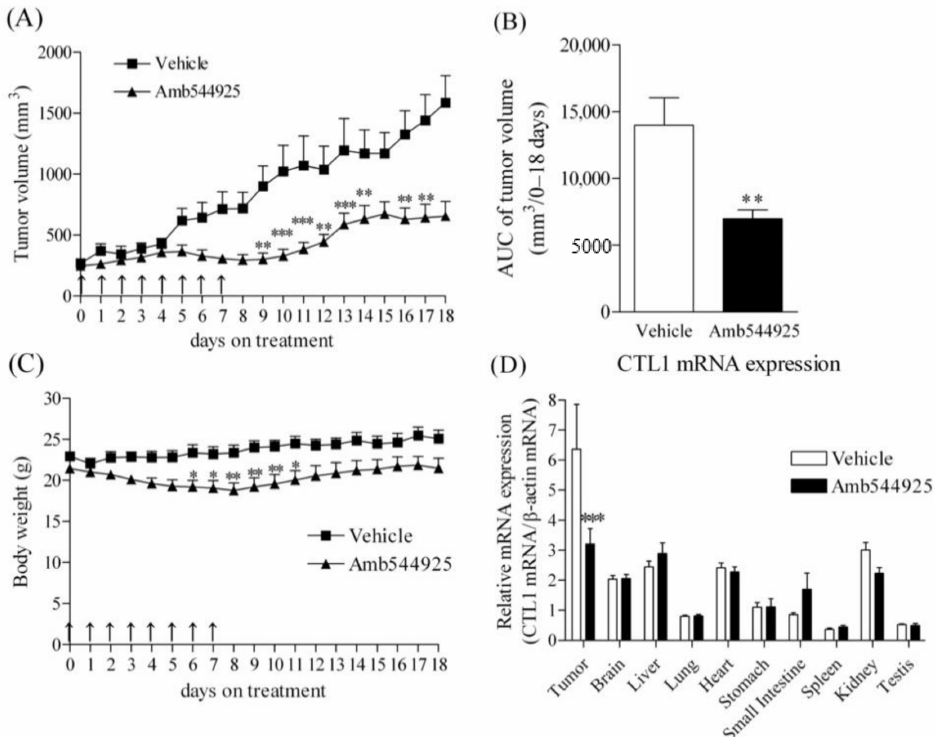
Figure 7. Effect of Amb544925 on tumor growth, body weight changes, and CTL1 mRNA expression in the HSC-3 human tongue cancer xenograft mouse model. ( A ) Tumor volumes were measured after intraperitoneal administration of 10 mg/kg Amb544925 ( n = 8 mice) and vehicle control ( n = 8 mice). The date of drug administration is indicated by an arrow. ** p < 0.01 and *** p < 0.005 compared to the vehicle control. ( B ) Area under curve (AUC) of tumor volume in each group over 0–18 days ( n = 8 mice). ** p < 0.01 compared to the vehicle control. ( C ) The body weight of mice was measured at the time of drug administration ( n = 8 mice). * p < 0.05 and ** p < 0.01 compared to the